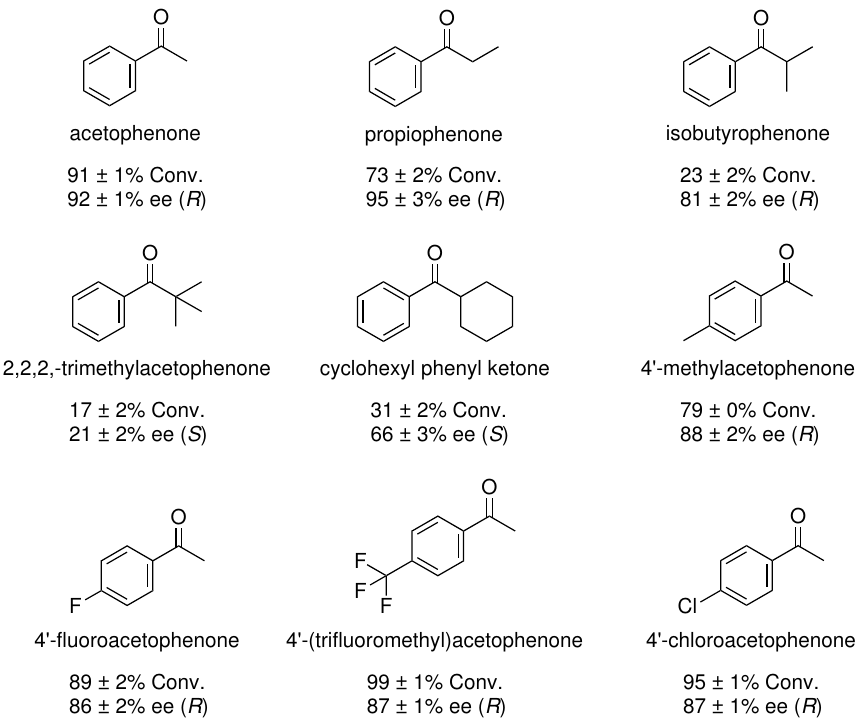
Figure 13. Substrate scope for ATH of ketones catalyzed by Ir(IMe) 2 ( L -Pro)(H)(I). All reactions were carried out using the optimized catalytic